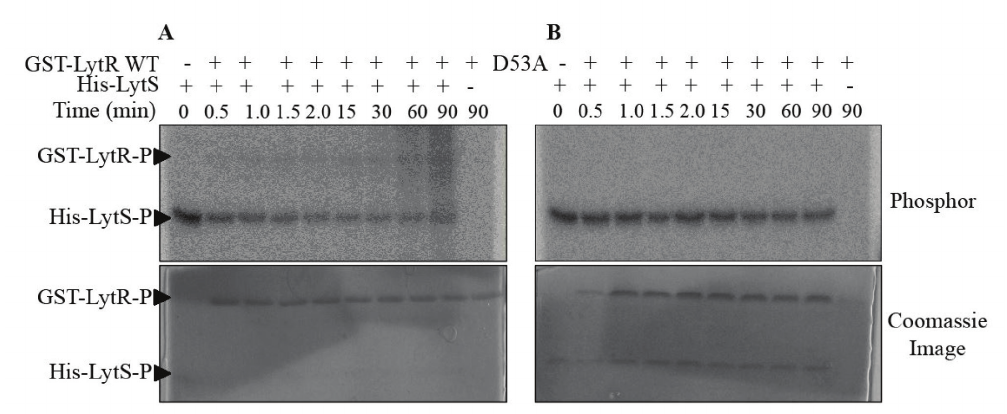
Figure 3. The phosphotransfer between His-LytS and GST-LytR or GST-LytRAsp53Ala variant. ( A ) Phosphorylated His-LytS at 4 µM was incubated with GST-LytR at 10 µM in PB at room temperature. The reaction was quenched at various time intervals and samples were analyzed by 15% SDS-PAGE. ( B ) Similar reaction as shown in ( A ), performed with GST-LytRAsp53Ala. The reaction was quenched at various time intervals and samples were analyzed by 15% SDS-PAGE. Gels were exposed to phosphor screen (GE Healthcare) overnight and imaged (top gels) using a Typhoon Trio + imager (GE Healthcare) followed with Coomassie blue staining (bottom